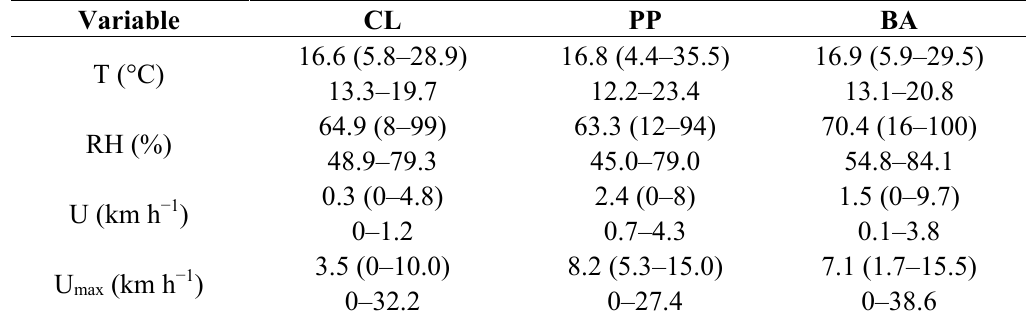
Table 2. Weather observations in the three stands: hourly observations means and ranges (first line, n = 2446, except for BA temperature, n = 2269) and range of mean daily observations (second line, n = 102).